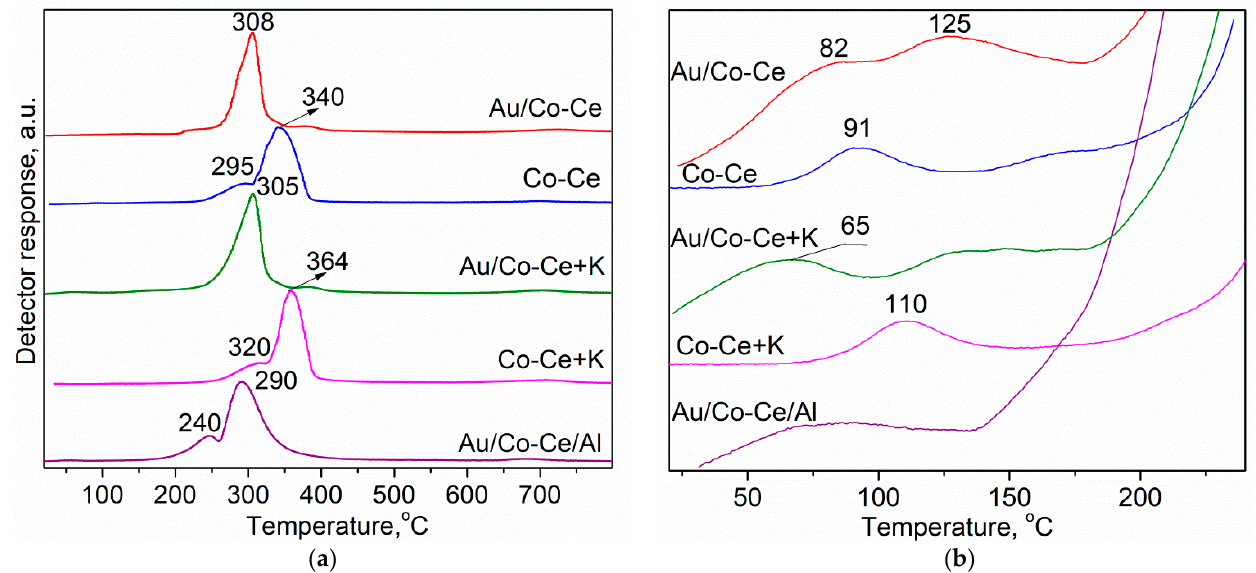
Figure 5. TPR profiles of the studied samples: ( а ) in the temperature range up to 800 °C; ( b ) in the temperature range up to 250 °C.